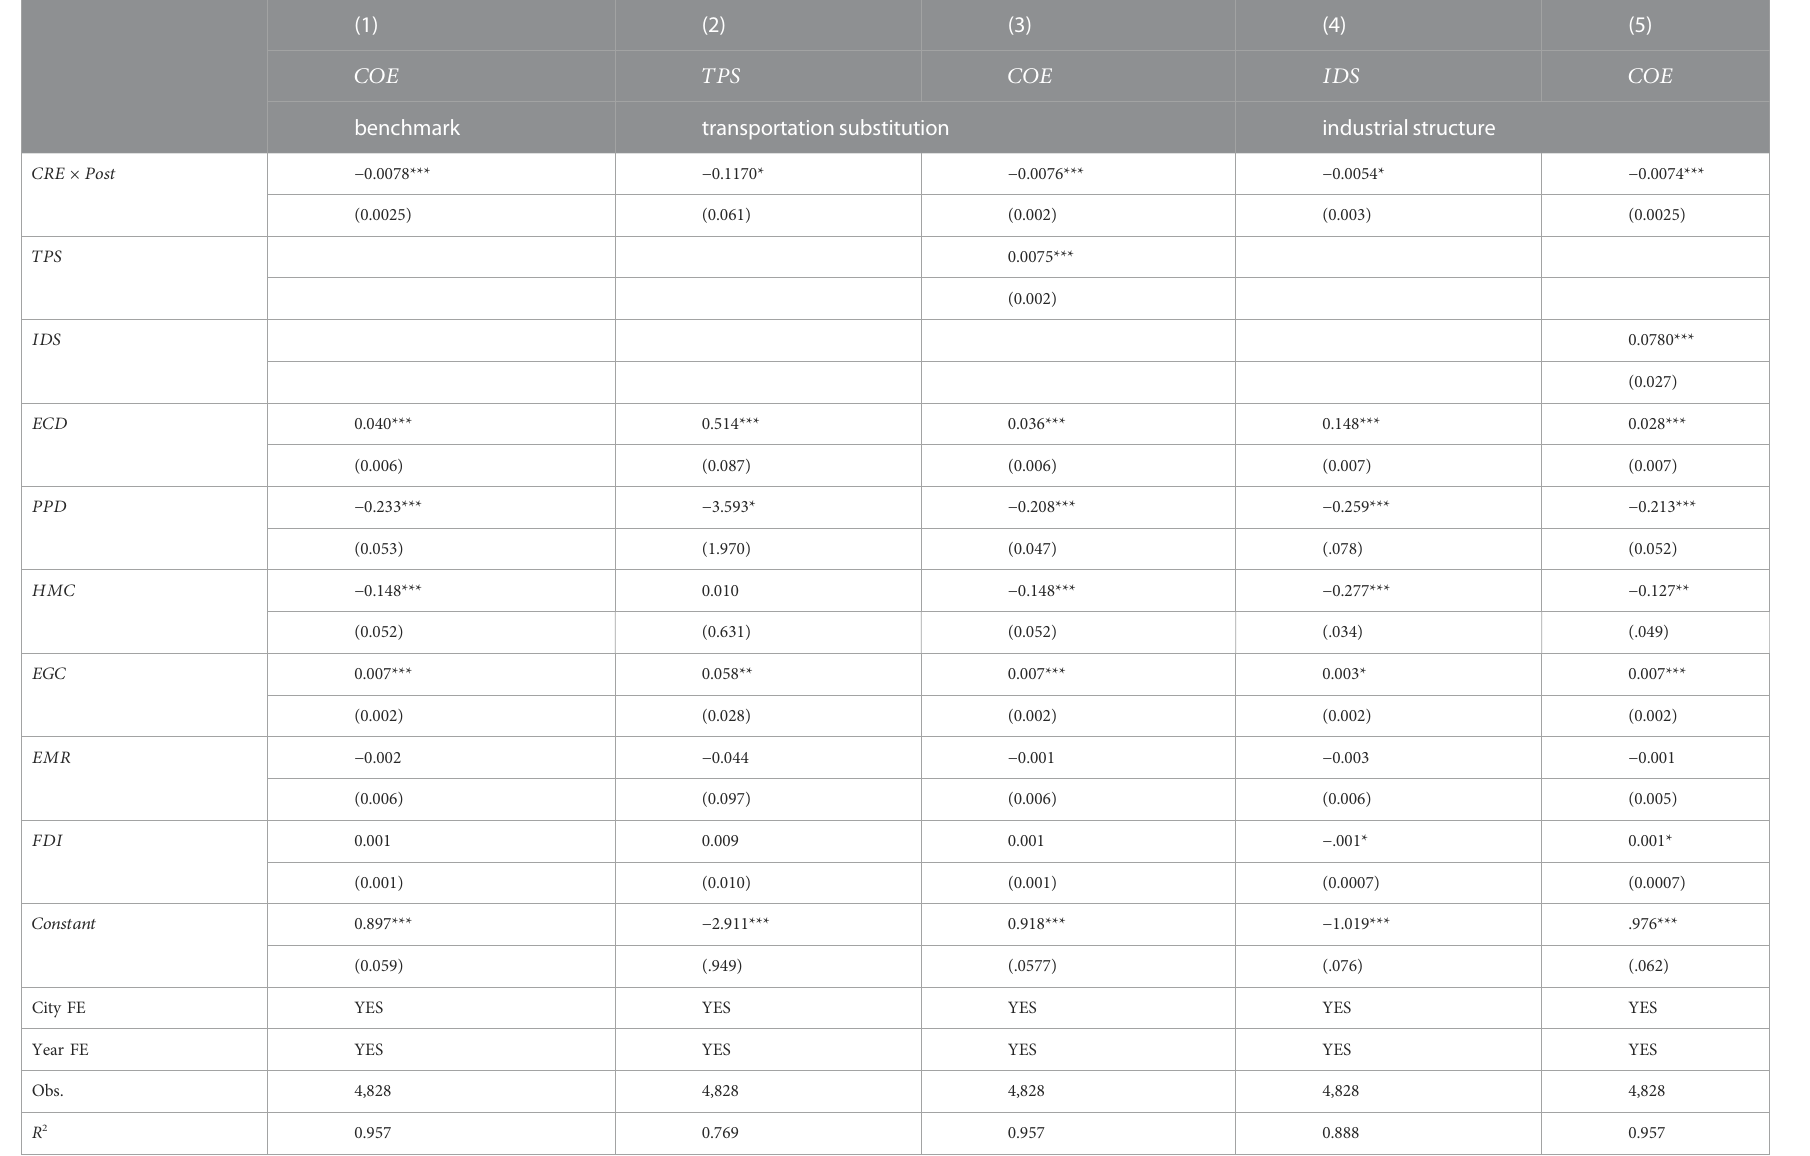
TABLE 5 The result of mechanism analysis: transportation substitution and industrial